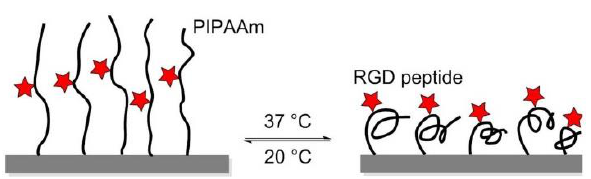
Figure 16. The thermoresponsive PIPAAm polymer undergoes expansion at 20 °C, and the RGD peptide remains hidden into the polymer. At 37 °C , the polymer shrinks and exposes the RGD peptide, promoting cell adhesion.